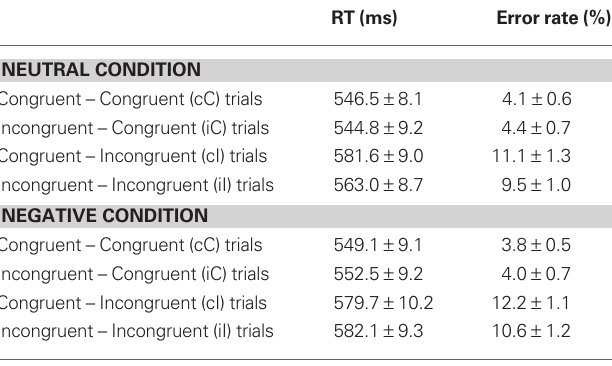
Table 1 | Descriptive statistics of the behavioral data.